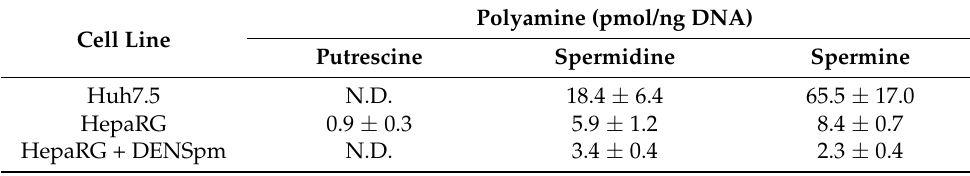
Table 1. Polyamine levels in cell